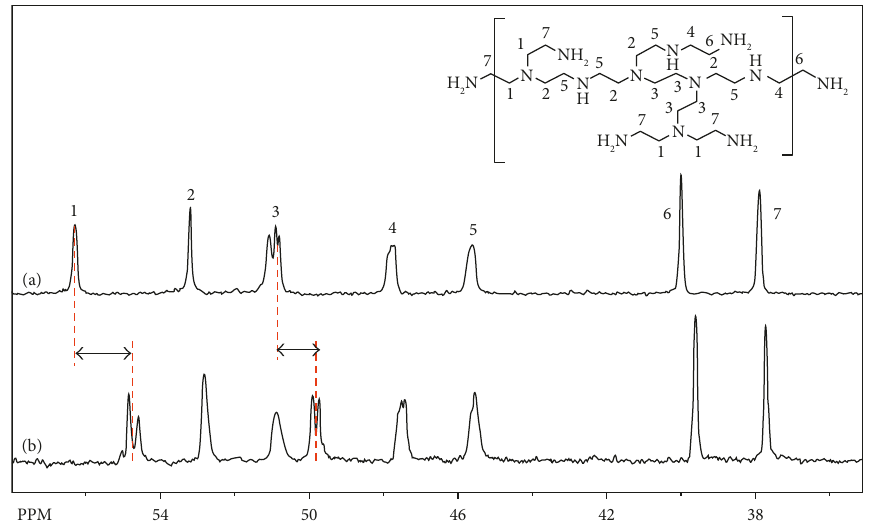
Figure 3: 13 C NMR spectrums for (a) PEI and (b) PEI-AuNPs in 2 H